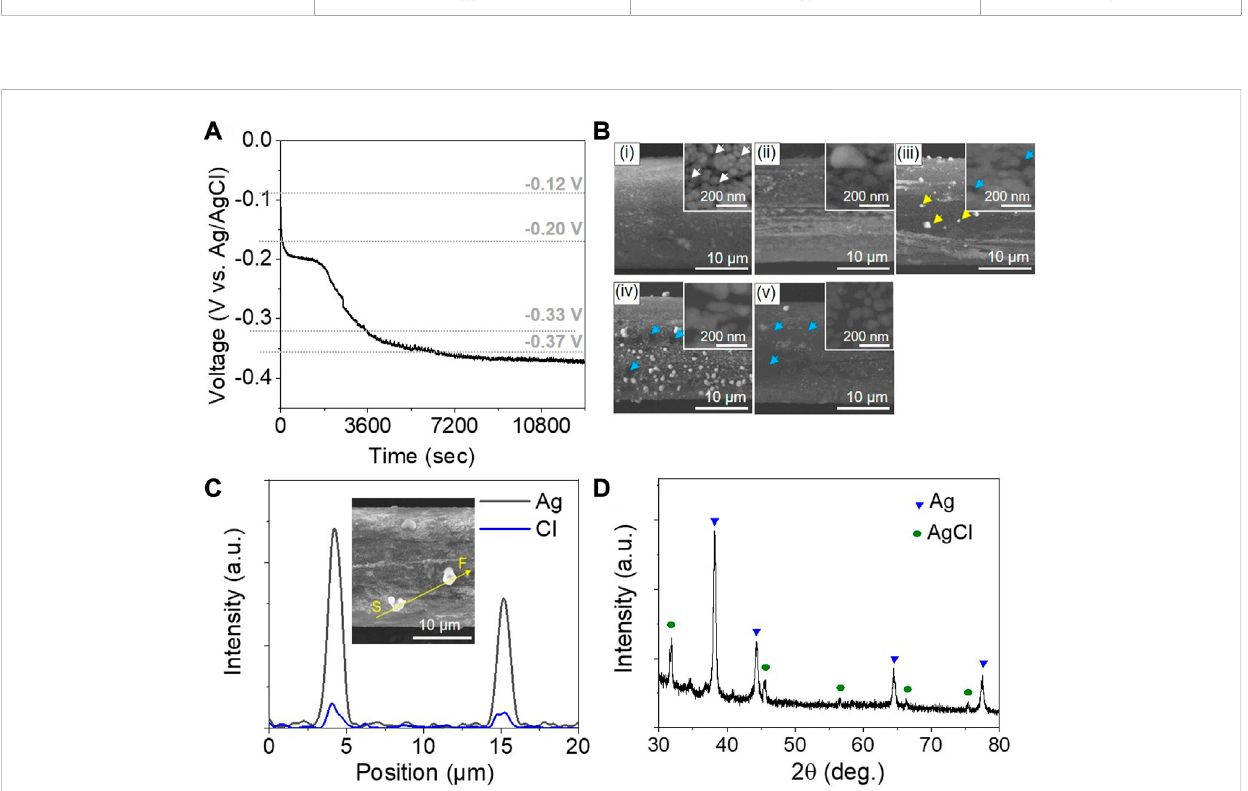
FIGURE 3 (A) Variation of open circuit potential (OCP) with the immersion time in a 1 M NaCl solution at 60 ° C. (B) SEM images of a strand of SCCY with the immersion times of (i) 200, (ii) 2000, (iii) 4000, (iv) 10000, and (v) 15000 s. The insets indicate magni fi ed SEM tip-view images. (White, yellow, and blue arrows indicate pinholes, silver chloride particles, and polymer fi ber, respectively.) (C) EDS line spectra of silver and chlorine on a strand of SCCY after an immersion time of 4000 s in a 1 M NaCl solution. (D) XRD pattern of the SCCY after an immersion time of 10,000 s in a 1 M NaCl solution at 60 °